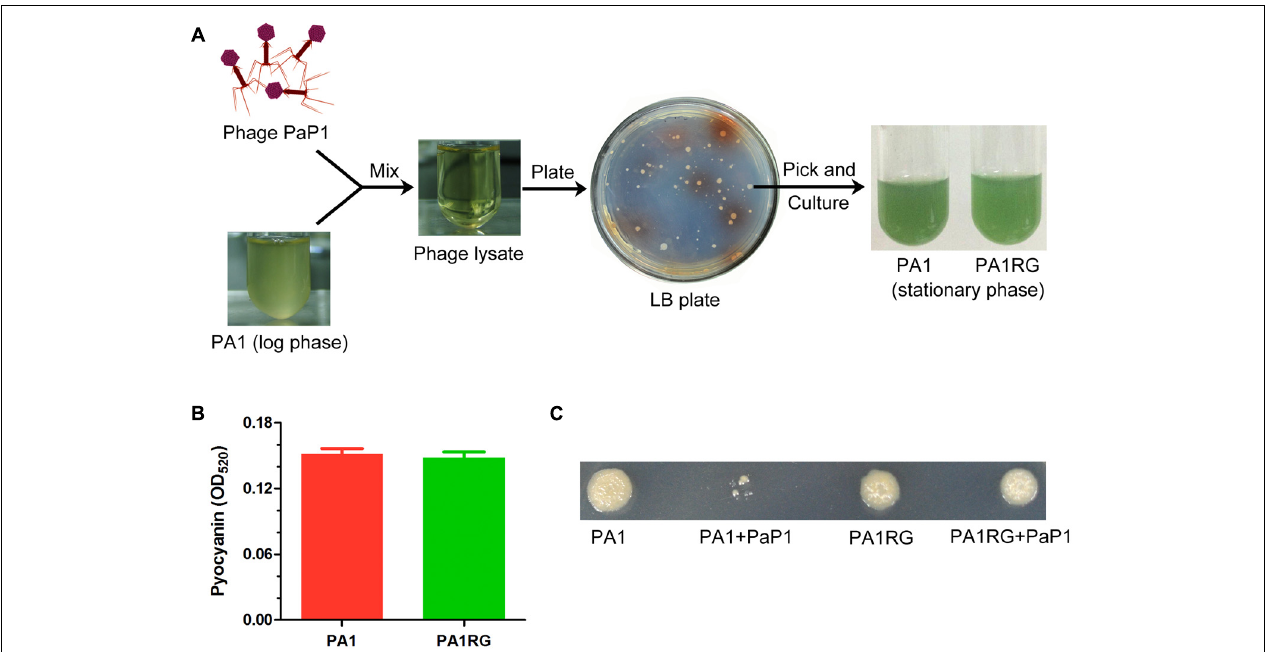
FIGURE 1 | Isolation of phage-resistant mutant PA1RG. (A) Diagram of PA1RG separation process. (B) Quantitation of pyocyanin production. Data were expressed as mean ± standard deviation (SD) from three biological replicates. (C) Dot assay on agar plate showed that PA1RG was steady resistant to phage PaP1.